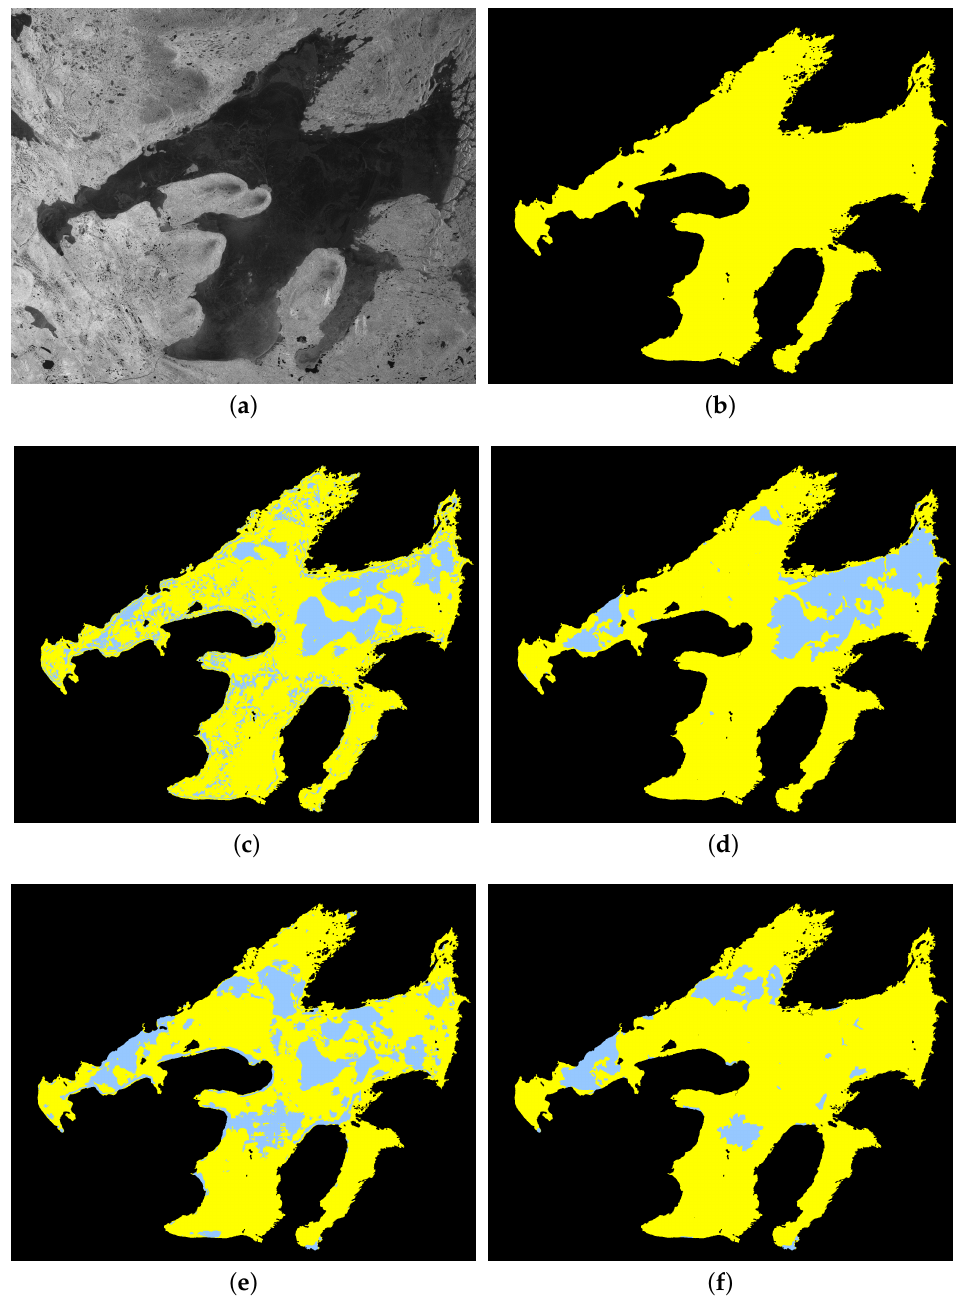
Figure 6. Ice-water classification of 25 May 2016 scene (scene ID: 20160525_144140). Ice is shown in yellow and water in blue. ( a ) HH image. ( b ) IRGS-Manual with accuracy of 100.0%. ( c ) SVM pixel-wise classification with accuracy of 76.5%. ( d ) IRGS-SVM; IRGS segmentation labeled by SVM with accuracy of 78.3%. ( e ) RF pixel-wise classification with accuracy of 70.0%. ( f ) IRGS-RF; IRGS segmentation labeled by RF with accuracy of